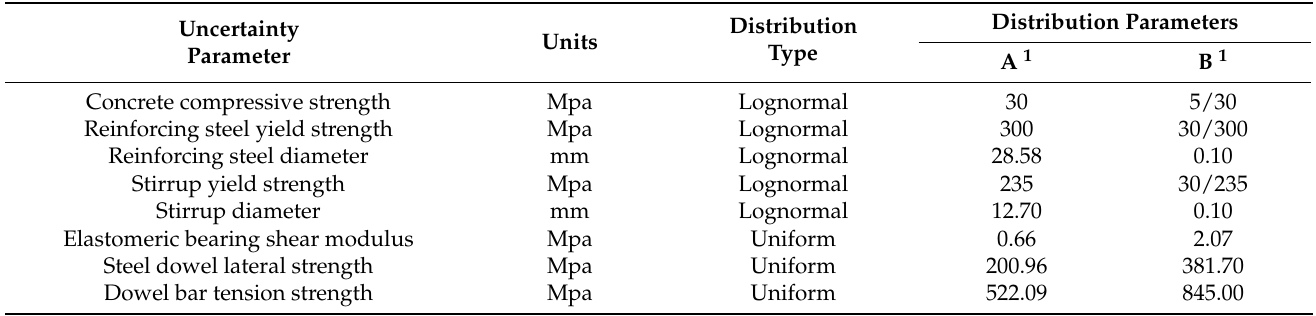
Table 3. Probability distribution of random parameters for bridge